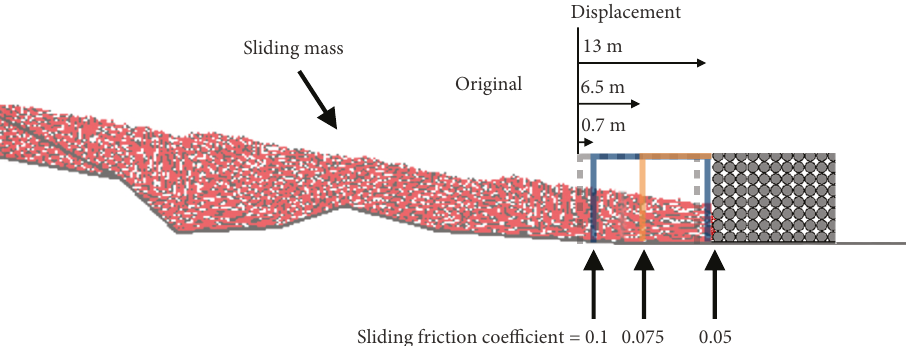
Figure 13: The sensitivity analysis for the relationship between the sliding friction coe ffi cient and the